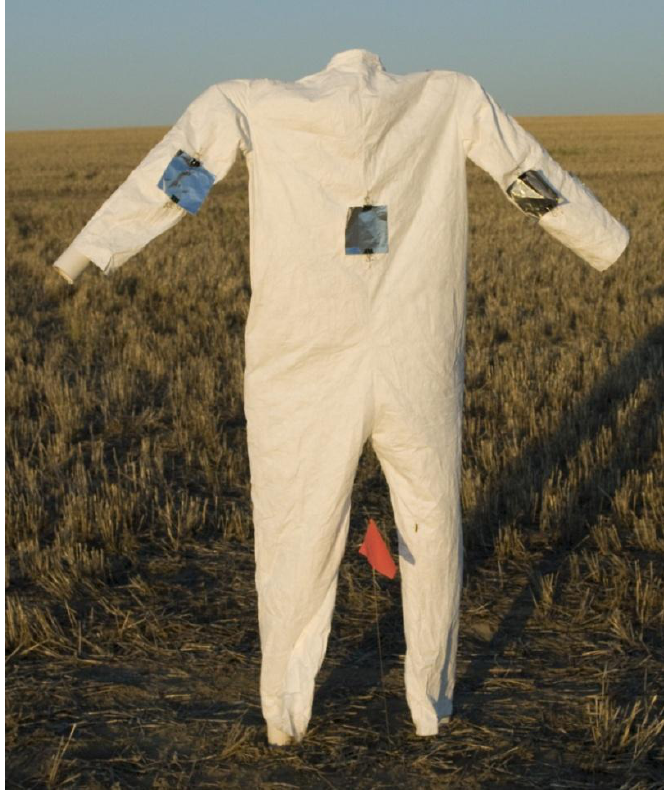
Figure 1. Mannequin bystander dressed Tyvek ® disposable coverall suit with one aluminum sampling patch on each arm and leg, upper chest, groin, and center of the back of each mannequin (only shown are the patches on the arms and chest) (photo: ©